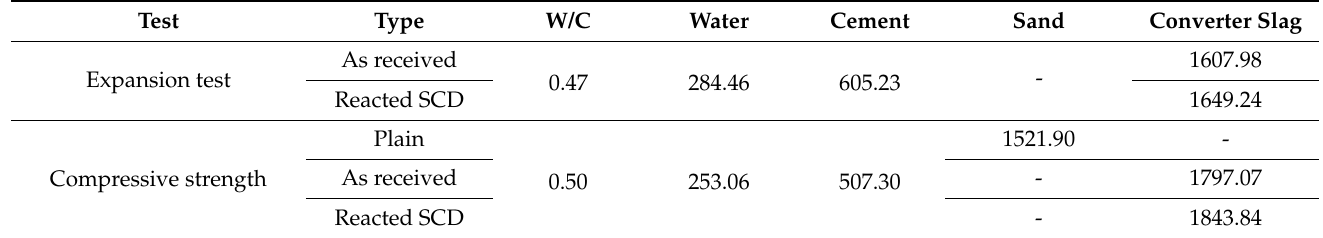
Table 2. Mix proportions of mortar specimen (kg/m 3